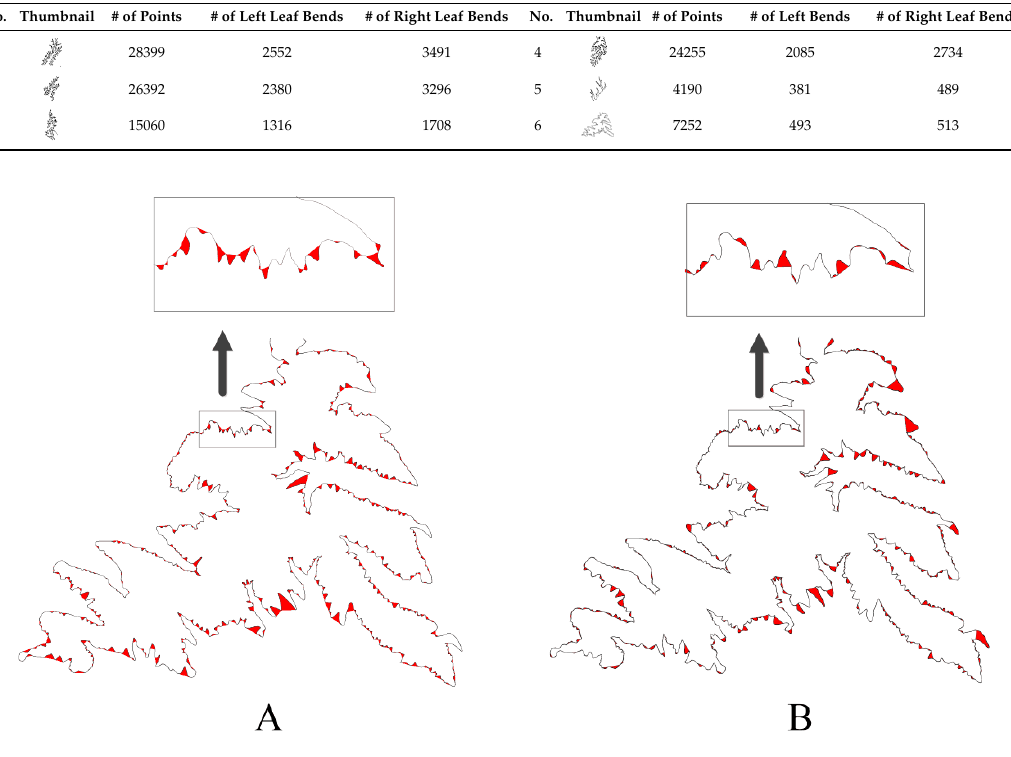
Figure 6. The ( A ) and ( B ) leaf bends and four close-ups along the No. 6 contour line in Table 1. Table 3. The LoD parameters for the left and right leaf bends of the No. 6 contour. Left Leaf Bend Right Leaf Bend Left leaf bend